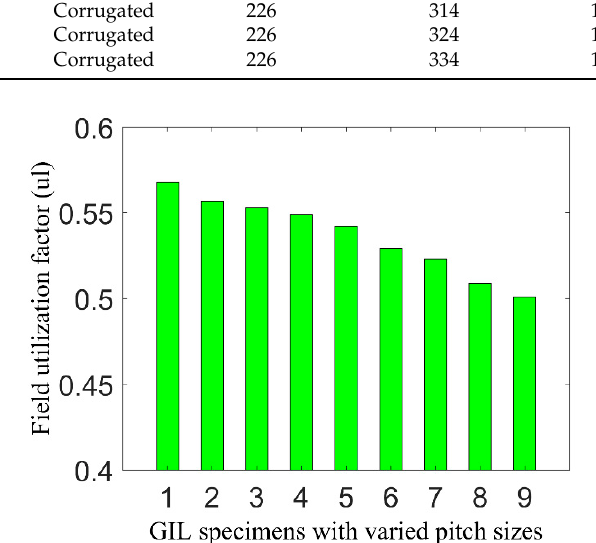
Figure 8. Field utilization factor comparison regarding varying pitch sizes of line enclosure.